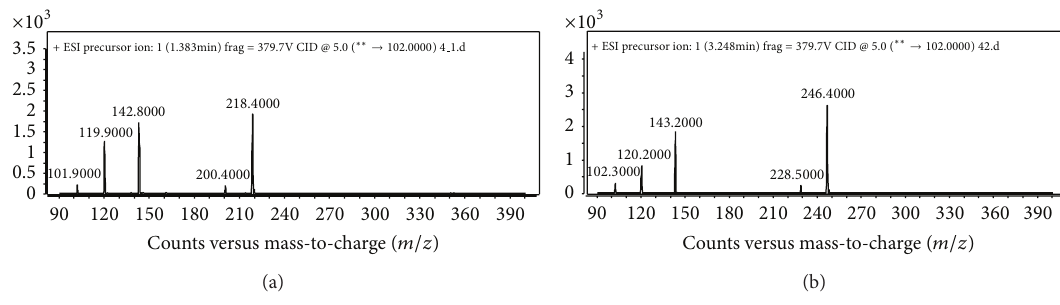
Figure 4: Mass spectrometry analysis of AHL produced by A. baumannii clinical isolate 4KT. (a) C6-HSL: retention time: 1.144min; m/z 200.400; abundance: 377.04; abundance%: 17.98. (b) C8-HSL: retention time: 3.105 min; m/z 228.100; abundance: 236.74; abundance%: